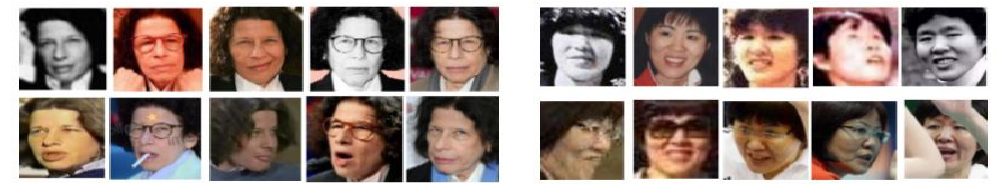
Figure 16. Example images from the VGGFACE2 dataset.